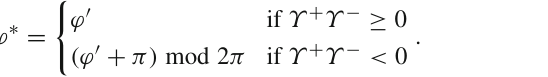
back in the z direction and the x -component of the π + momentum is zero. c The transverse mass m tot , defined in [31]. The observables Υ ( d ) T = m = and O ∗ ( e ), defined in Eqs. (2) and (4), respectively, are required for the H A computation of ϕ ∗ , along with the momentum vectors of the tau decay products. The distribution of ϕ ∗ is shown in ( f ). The green graph below each plot shows the ratio of the A -event and H -event